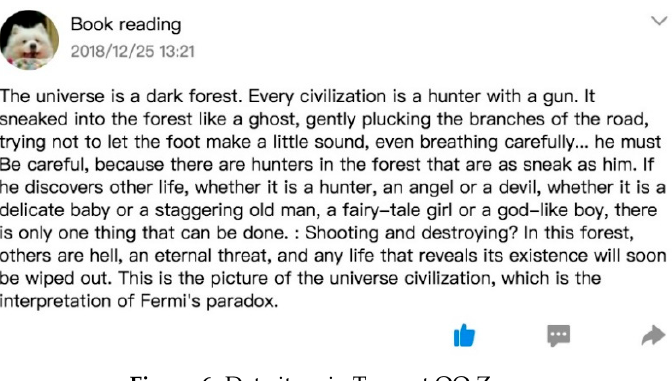
Figure 7. Data item in Sina Weibo. Figure 8. Data item in Netease News. 4.1.2. Unified Model Building The data collected is complex and has different forms, so it is necessary to establish a unified model. Two items, including time and content in data from Tencent QQ Zone and Sina Weibo, and three items, including title, time, and content in data from Netease News, are kept. The data preprocessing is required, including repeated data filtering, word segmentation, removal of stop words, and so on. The data to be preprocessed here mainly includes content from three sources, and the text title in the Netease News data. For data in Tencent QQ Zone and Sina Weibo, some entity words are chosen from content as the labels. For data from Netease News, title segmentation results can be considered to be the labels. Mixing these three kinds of data, the unified model can be obtained. A unified data of this model is shown in Figure 9. Figure 9. Single data in unified model.